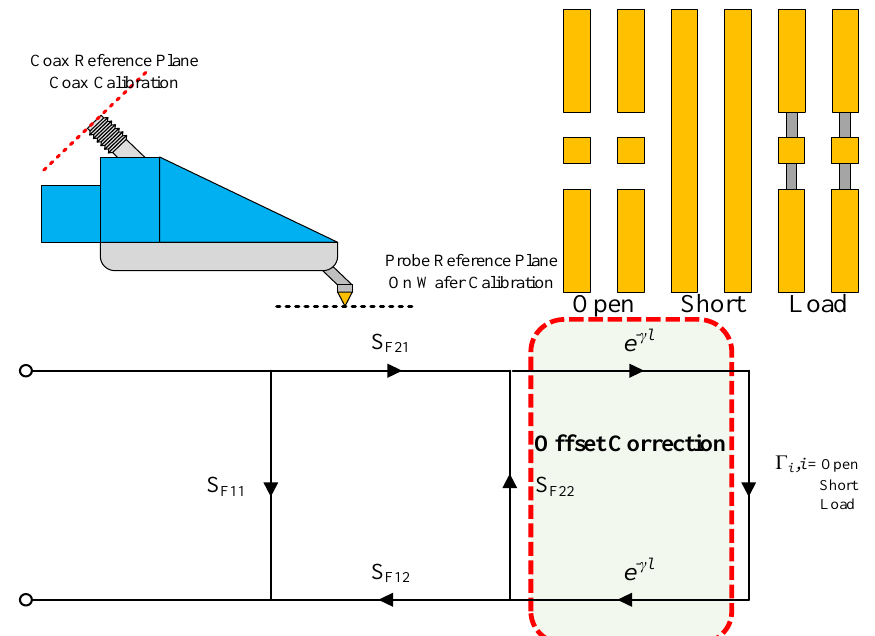
Figure 3. OSL de-embedding flow.